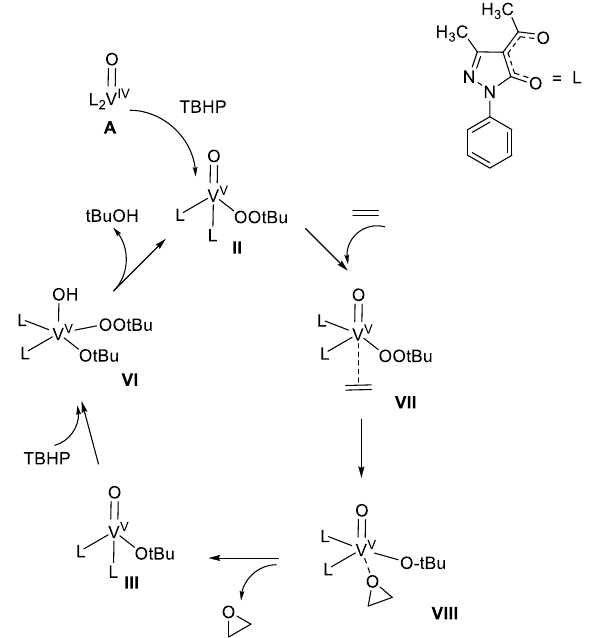
Figure 8. Sketch of the likely catalytic cycle operative under the TBHP oxidation promoted by oxidovanadium complex A .